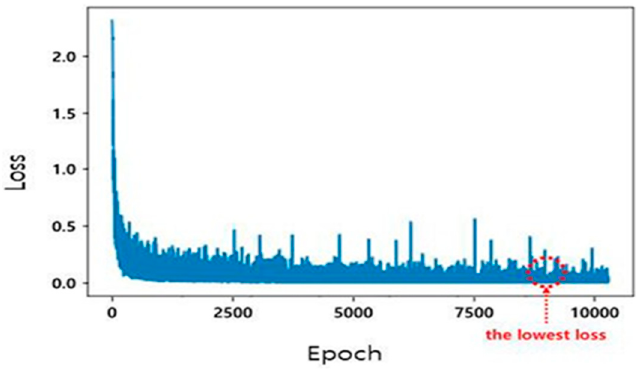
Figure 14. Loss value according to epoch for the Cityscapes database.